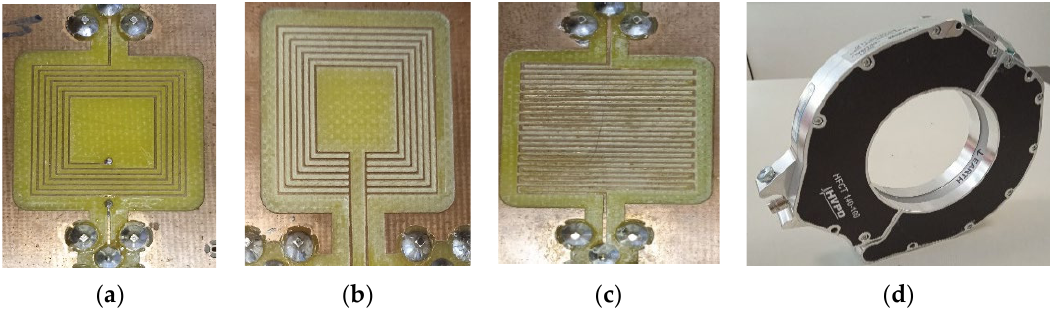
Figure 7. Inductive sensors tested in the experiment setup: ( a ) spiral, ( b ) non-spiral, ( c ) meander, and ( d ) the HFCT.